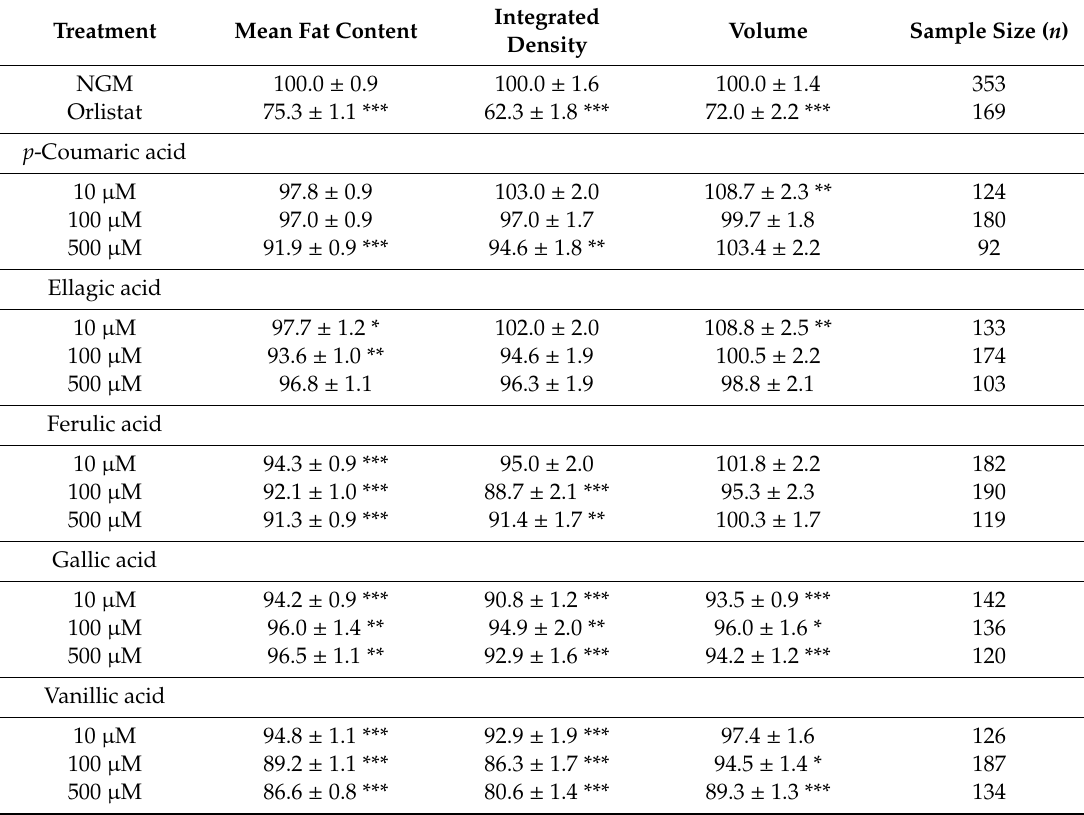
Table 2. C. elegans lipid quantification data (relative to NGM) obtained after phenolic acids treatment and measured by Nile Red staining. Data correspond to the mean ± SEM. *, **, *** show the level of statistical significance of the differences, p < 0.05, p < 0.01, and p < 0.001, respectively.